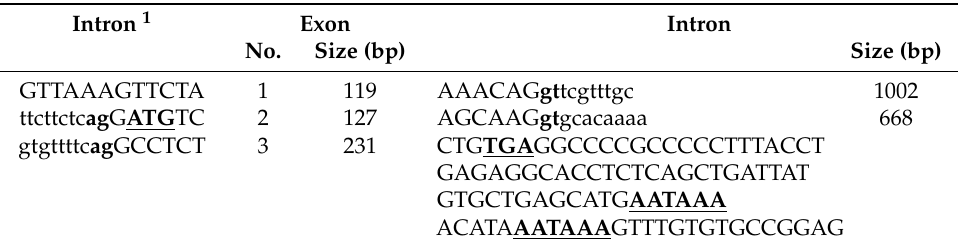
Figure 1. Position of five genetic markers in the SD region of Oreochromis aureus delineated on the O. niloticus genome map. Genetic markers (red arrows) were developed within paics-1 (long form), banf2 ( LOC102076719 ), paics-2 (short form) and forkhead box protein M1-like ( foxm1l ). The SD region spanned 235 Kbp between the two external markers. Table 2. Genomic organization of the Oreochromis aureus banf2w